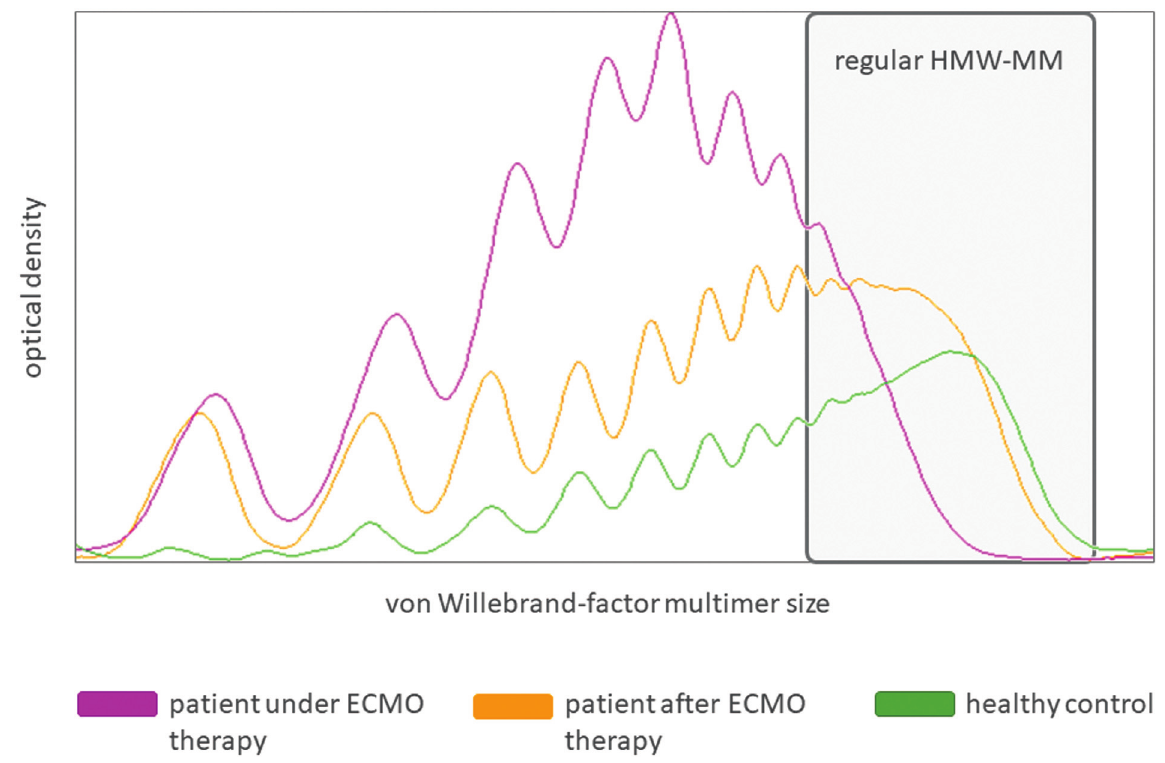
Fig 2 von Willebrand factor (VWF) multimer distributions on day 3 after bleeding occurred under and after ECMO therapy compared to healthy control. ECMO, extracorporeal membrane oxygenation; HMWMM, high molecular weight